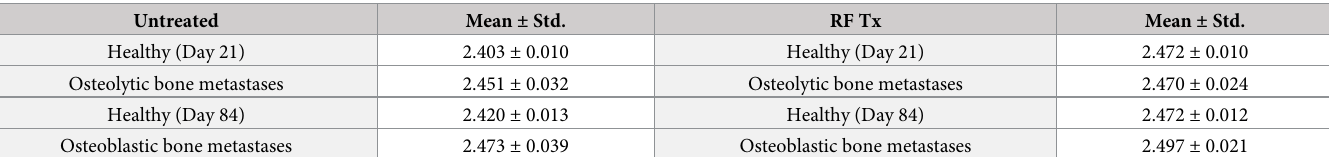
Table 1. Susceptibility Ratio (R). Untreated Mean ± Std. RF Tx Mean ± Std.